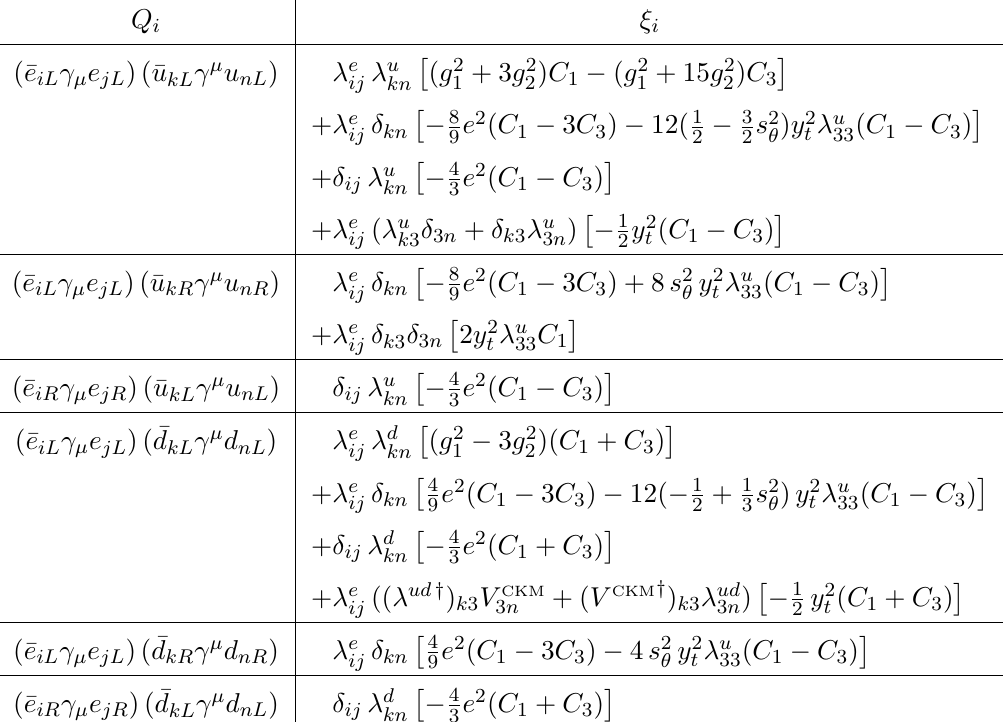
Table 4 . Operators Q i and coe(cid:14)cients (cid:24) i for the semileptonic part of the e(cid:11)ective Lagrangian L EW involving charged leptons and neutral currents. Generation indices run from 1 to 3, exception e(cid:11) made for up-type quarks where k; n = 1 ; 2. We set sin 2 (cid:18) W (cid:17) s 2